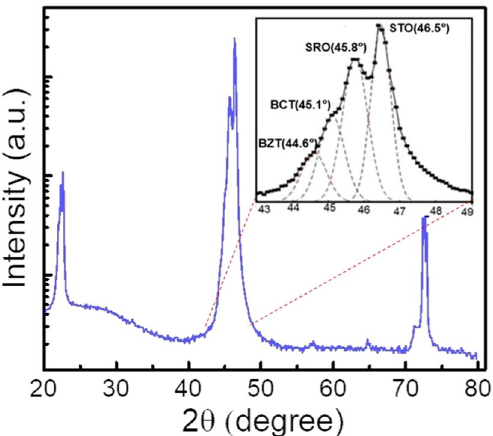
Figure 3. XRD patterns of the heterostructures BZT/BCT on SRO deposited STO (100) substrate recorded at room temperature. Inset displays the enlarged version of (002) peaks of BZT, BCT, SRO, and STO.